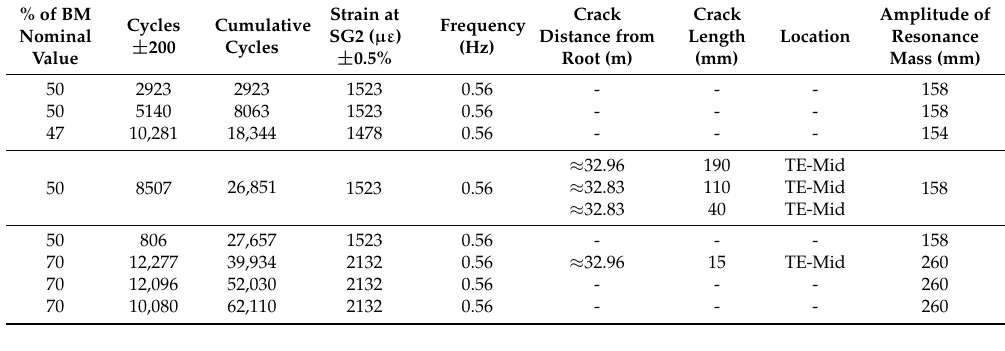
Table 4. Fatigue test condition and results for the blade with a 200 mm crack.